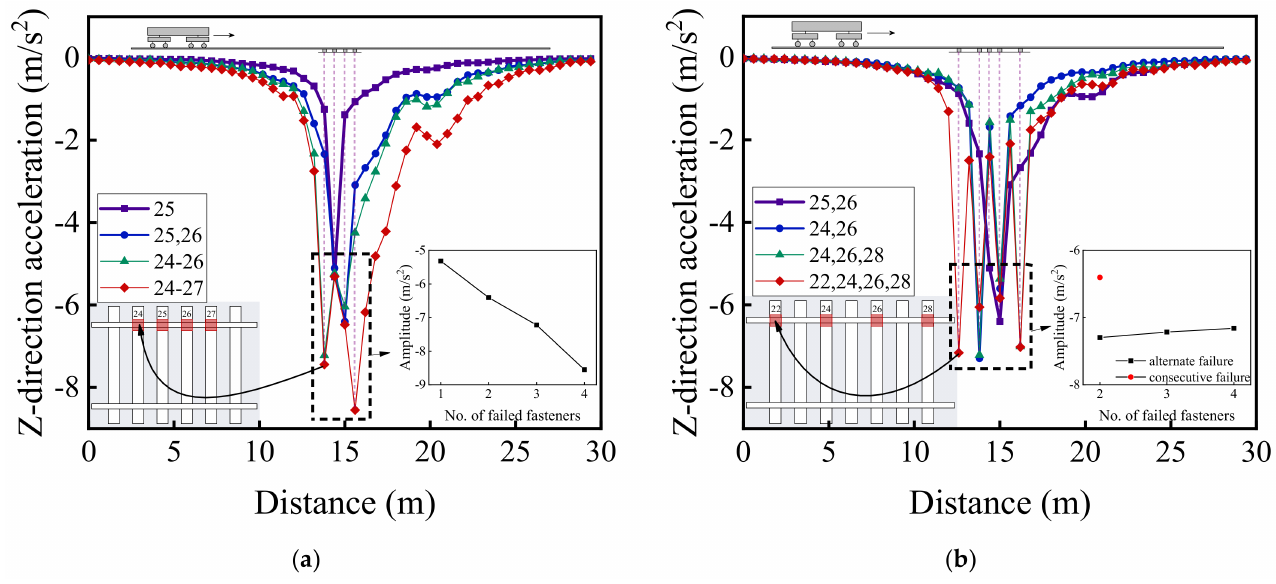
Figure 22. The longitudinal variations of vertical acceleration responses of sleepers (under No. 1 to No. 50 rail node) with ( a ) single-side consecutively failed fasteners and ( b ) single-side alternately failed